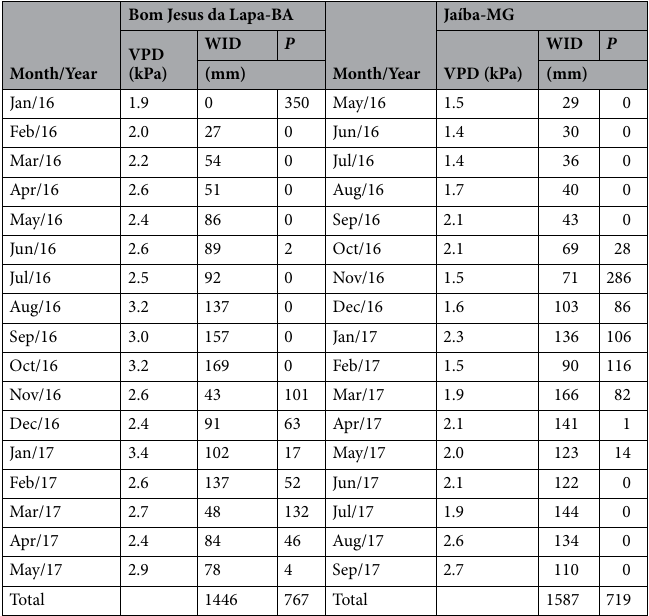
Table 1. Monthly mean values of vapor pressure deficit (VPD in kPa) and monthly cumulative values of water irrigation depth (WID in mm) and precipitation (P in mm) along the months of experiment in Bom Jesus da Lapa-BA and